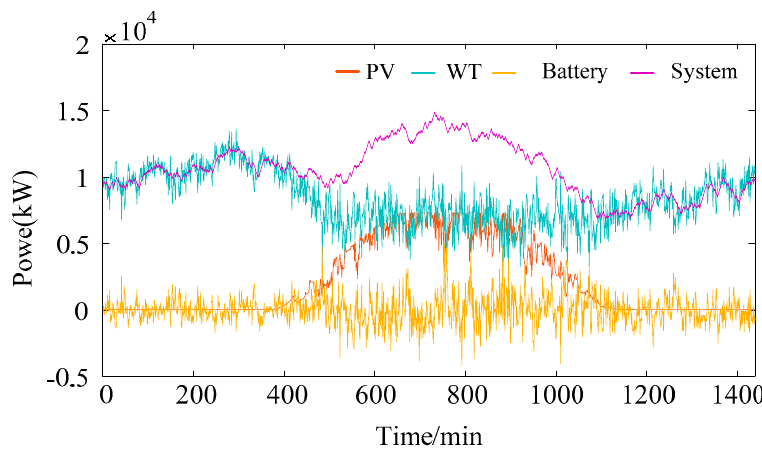
Figure 9. Output of equipment in scenario 2.